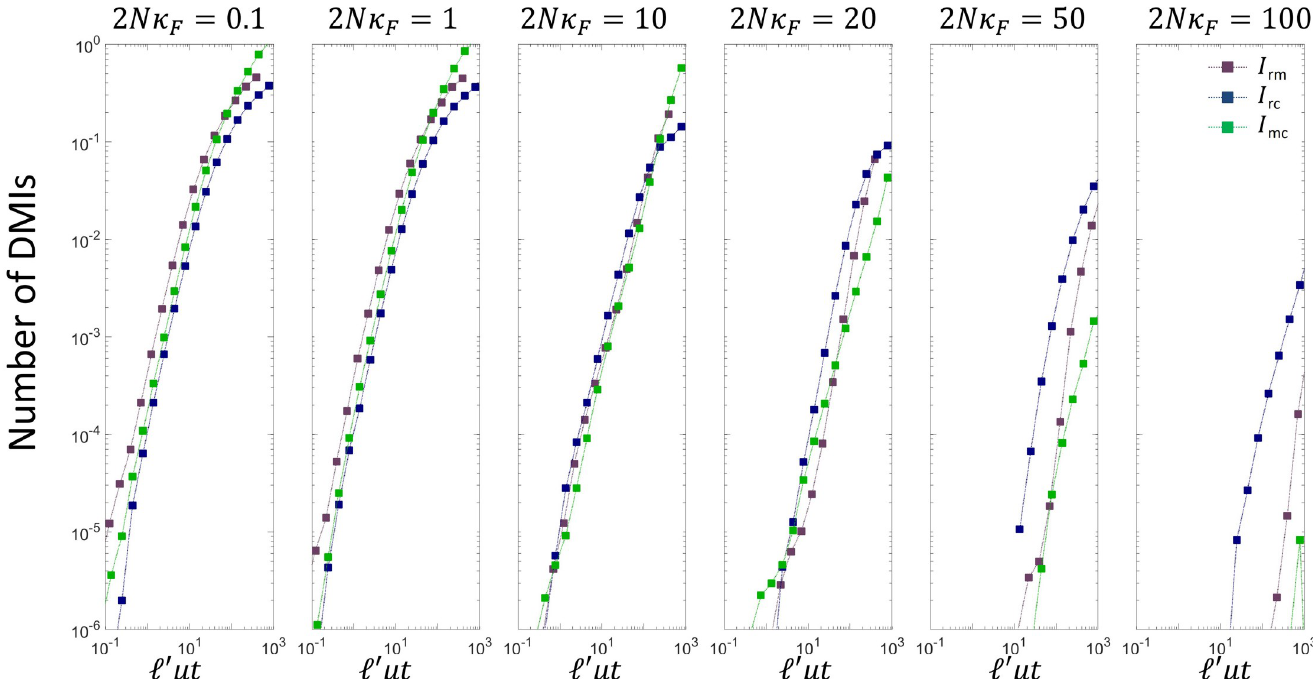
Fig 6. Plot of the spectrum 2-way DMIs vs scaled divergence time for different scaled population sizes. Here the divergence time for each pair-wise DMI is scaled by the number of base-pairs involved in each interaction in order to remove the effect that interactions with a larger number of base-pairs mutate at a larger rate in proportion to their length; for I rm , ℓ 0 = 5, and for I rc and I mc , ℓ 0 = 10.